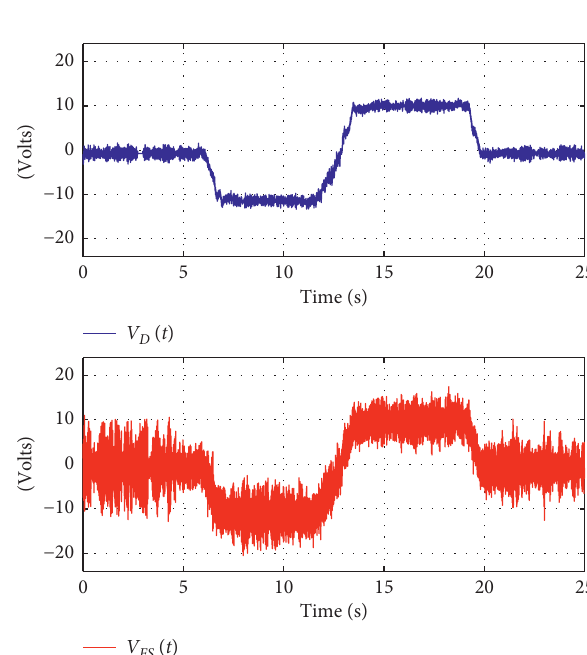
Figure 20: θ performance. 2